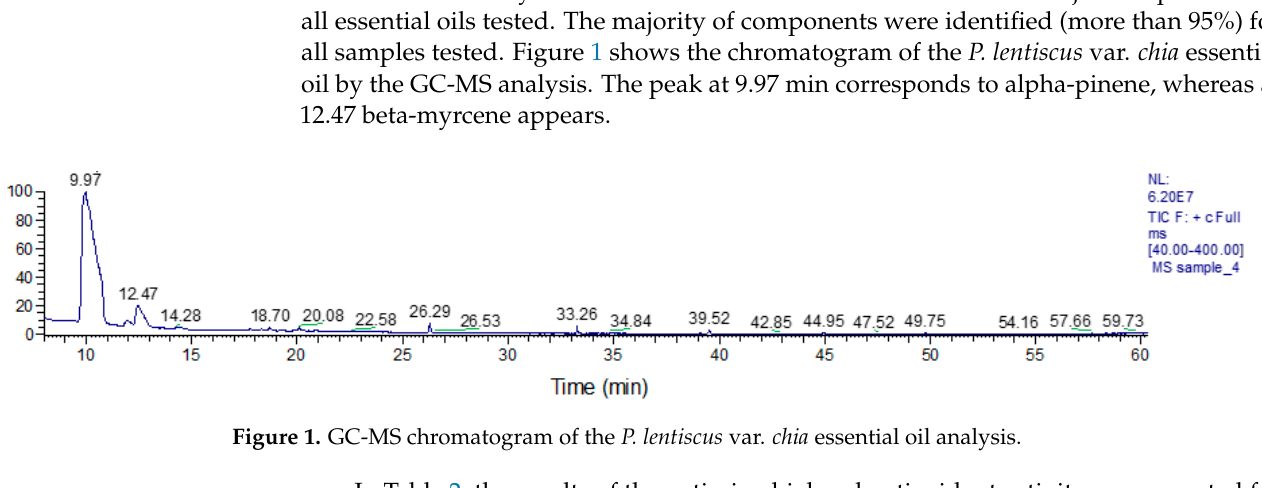
Table 2. Minimum lethal concentration (MLC) ( n = 3) and total phenolic content (TPC) ( n = 3) of the six essential oils